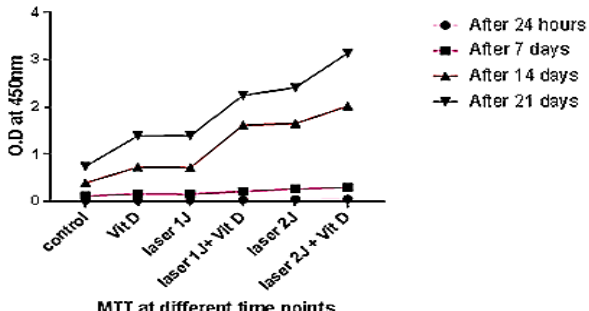
Figure 4: RUNX2 gene expression shows statistically significant difference between all groups (p < 0.0001) with a significant difference between groups with laser irradiation of 1 J/cm 2 and 2 J/ cm 2 (p = 0.0001). The values were measured relative to GAPDH gene